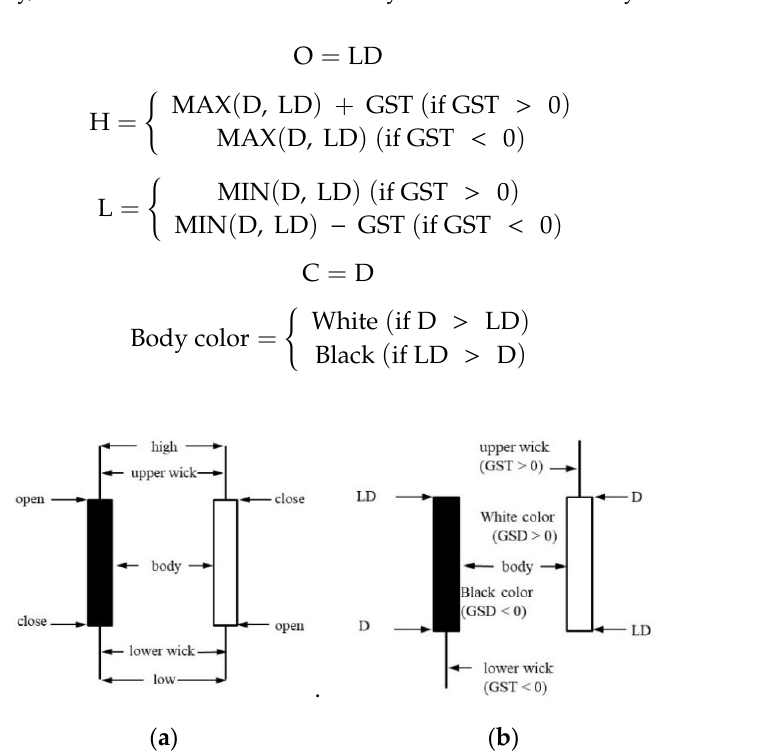
Figure 1. Candlestick. ( a ) Stock market data; ( b ) Sports data. The difference between “open” and “close” is treated as the gambling shock related to the line on the winning/losing margin between the team and its opponent, denoted as GSD; The difference between LT (the line on the total points scored by both teams) and T (the actual total points scored) is treated as the gambling shock related to the line on the total points scored by both teams, denoted as GST.